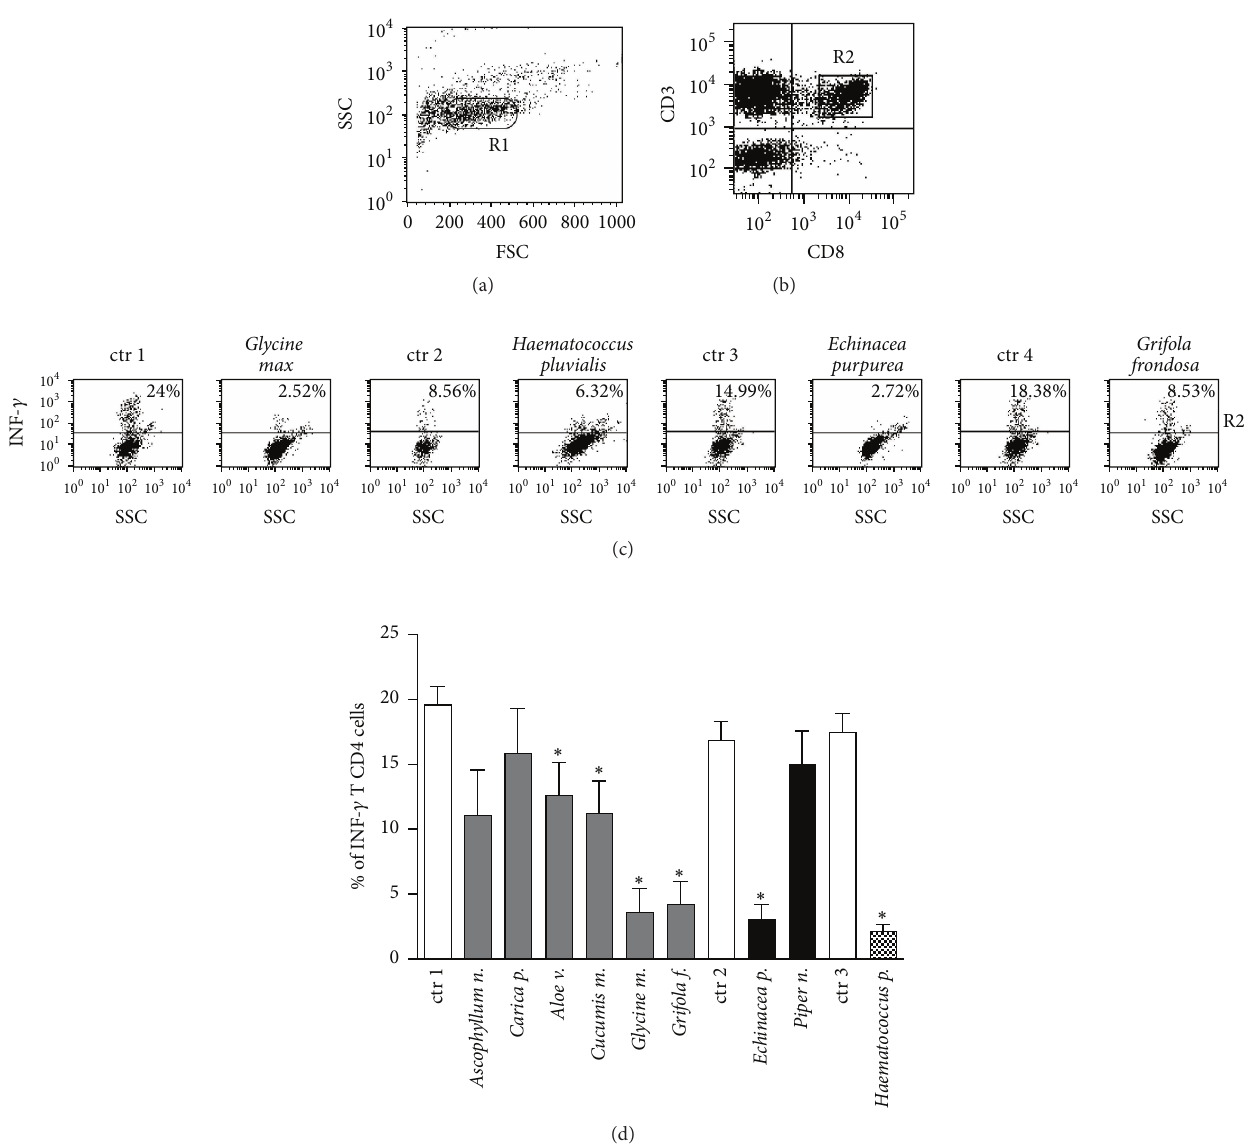
Figure 2: The effects of botanicals on INF- 𝛾 production by canine PBMCs. (a) shows the gating on viable lymphocytes (R1 in dot plot graph) based on FSC and SSC parameters (see Section 2). (b) represents the gating on CD4 + T lymphocytes (CD3 + CD8 − as R2 in the dot plot graph). (c) reports the results from one representative experiment showing the percentage (the number in upper quadrant) of INF- 𝛾 producing canine CD4 + T lymphocytes gated on R2 ( 𝑦 -axis); 𝑥 -axis indicates the SSC parameter (see Section 2). The different coincubations of cells with ad hoc medium or mixture (see Section 2) are indicated on the top. (d) shows the statistic representation the INF- 𝛾 production by canine CD4 + T Lymphocytes evaluated as percentage of INF- 𝛾 producing cells in 10 representative experiments, ∗ 𝑝 < 0.05 . The abbreviation “ctr” in (c) and (d) indicates the basal INF- 𝛾 production by PMBCs stimulated by PMA and Ionomycin and in presence of the ad hoc medium based on the same solubilizing-vehicle but free from the botanicals (see Section 2): specifically, ctr 1 ( Ascophyllum n. , Carica p. , Aloe v. , Cucumis v. , Glycine m. , and Grifola f. ), ctr 2 ( Echinacea p. , Piper n. ), and ctr 3 ( Haematococcus p.